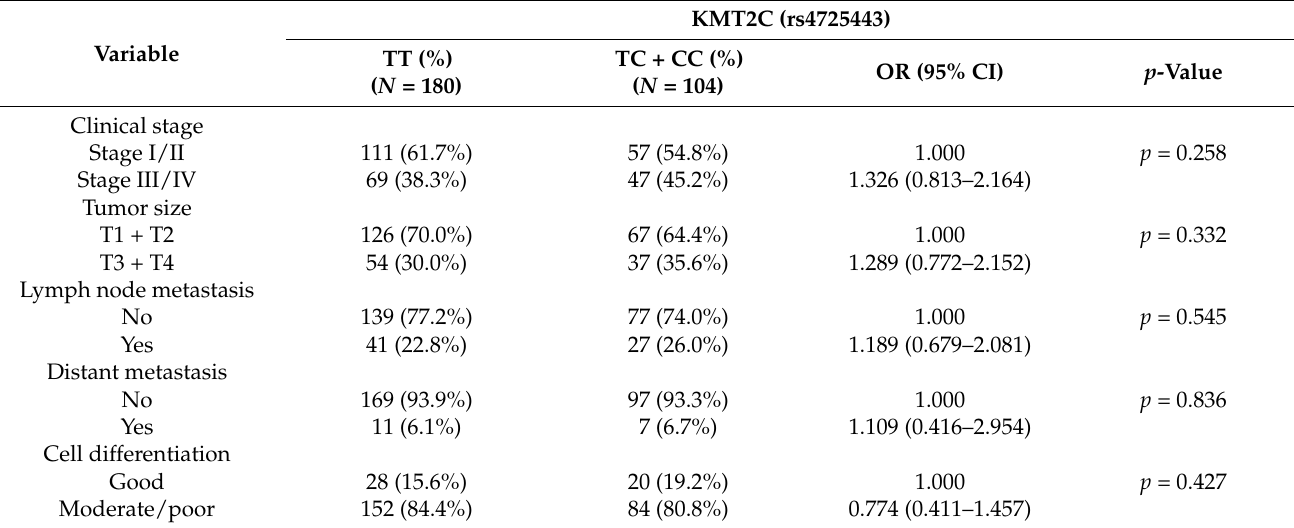
Table 3. Clinical statuses and KMT2C rs4725443 genotype frequencies in cases-of-OSCC